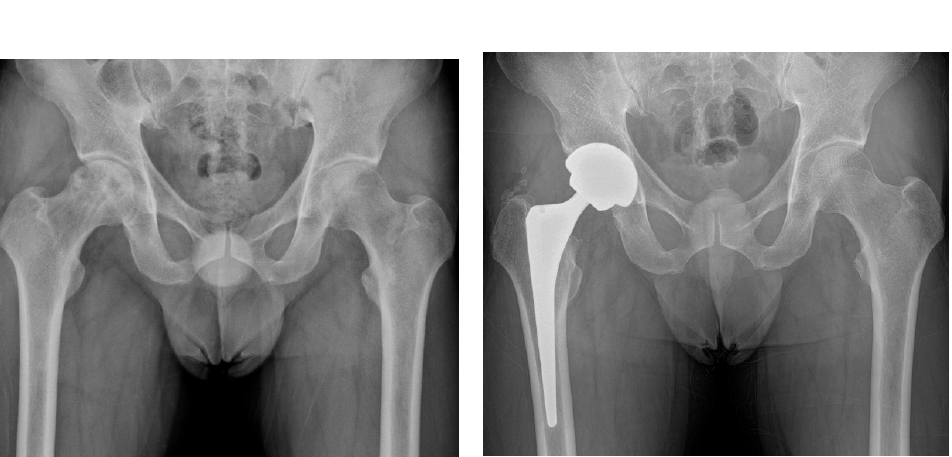
Figure 3. ( A ) Preoperative hip radiograph of a 41-year-old man who had undergone surgical removal